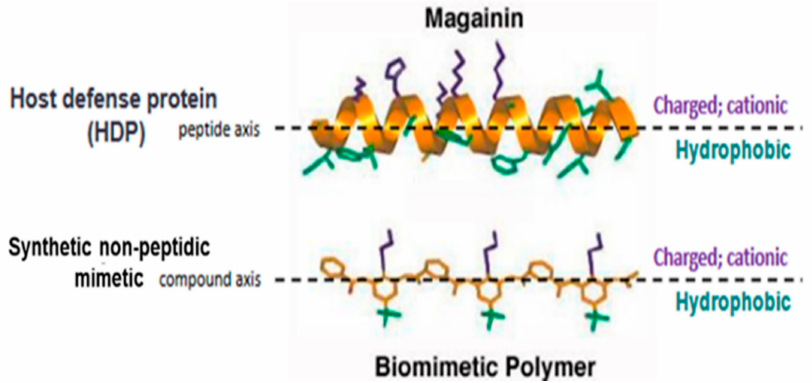
Figure 1. Structure of brilacidin. Schematic representation of the amphiphilic α -helix structure of the Host Defense Protein/Peptide (HDP) magainin above that of a synthetic nonpeptidic mimetic polymer, such as brilacidin, capturing the structural and biological properties of HDPs using fully synthetic, nonpeptidic scaffolds and